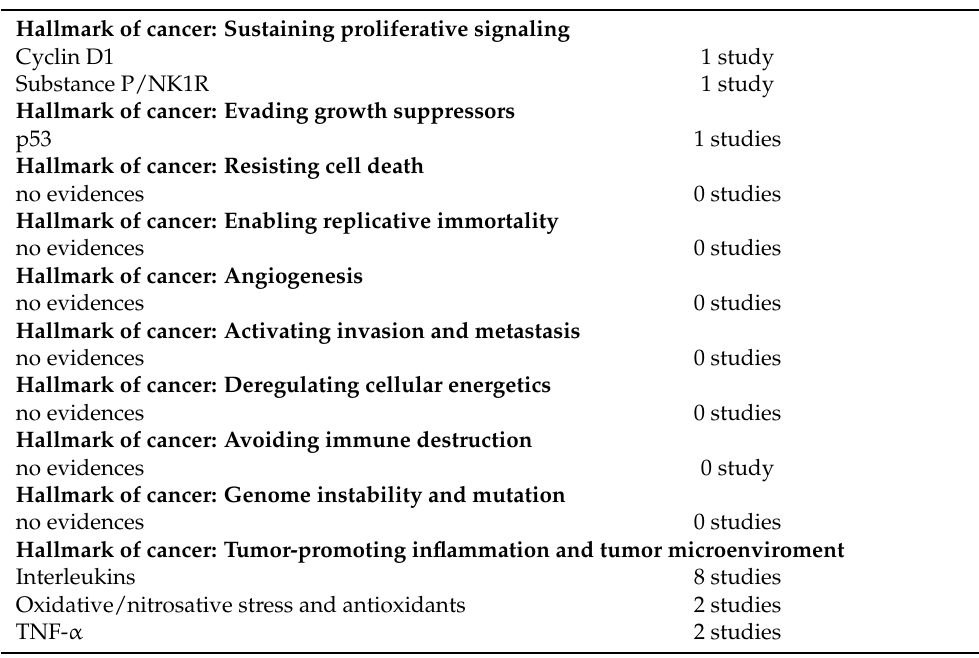
Table 2. Summarized evidence derived from the research on the hallmarks of oral cancer and biomarkers investigated in patients with OLP across secondary-level systematic